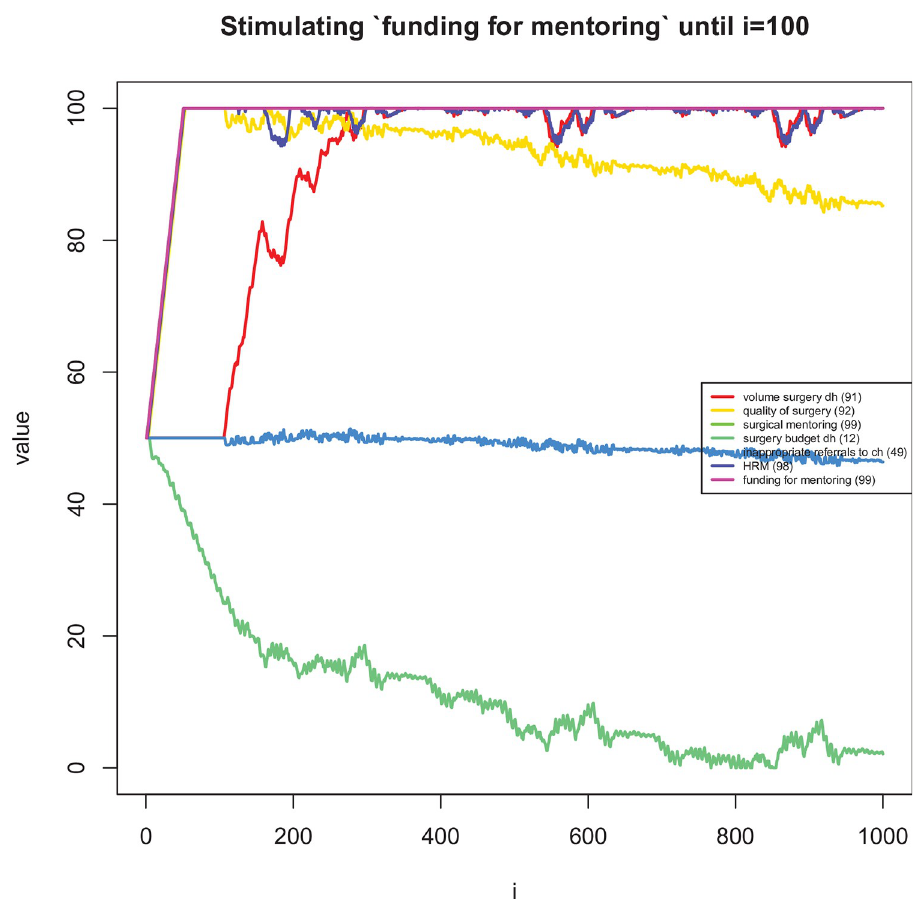
Fig 8. Long term dynamic explorations of the effects on changes in ‘funding for mentoring’ for the first 100 time periods.